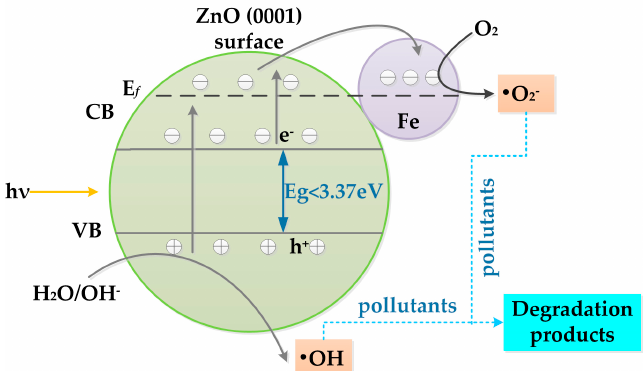
Figure 8. Schematic explanation of the transfer of electron–hole pairs in iron-adsorbed ZnO (0001) surface leading to the degradation of pollutants under sunlight irradiation.